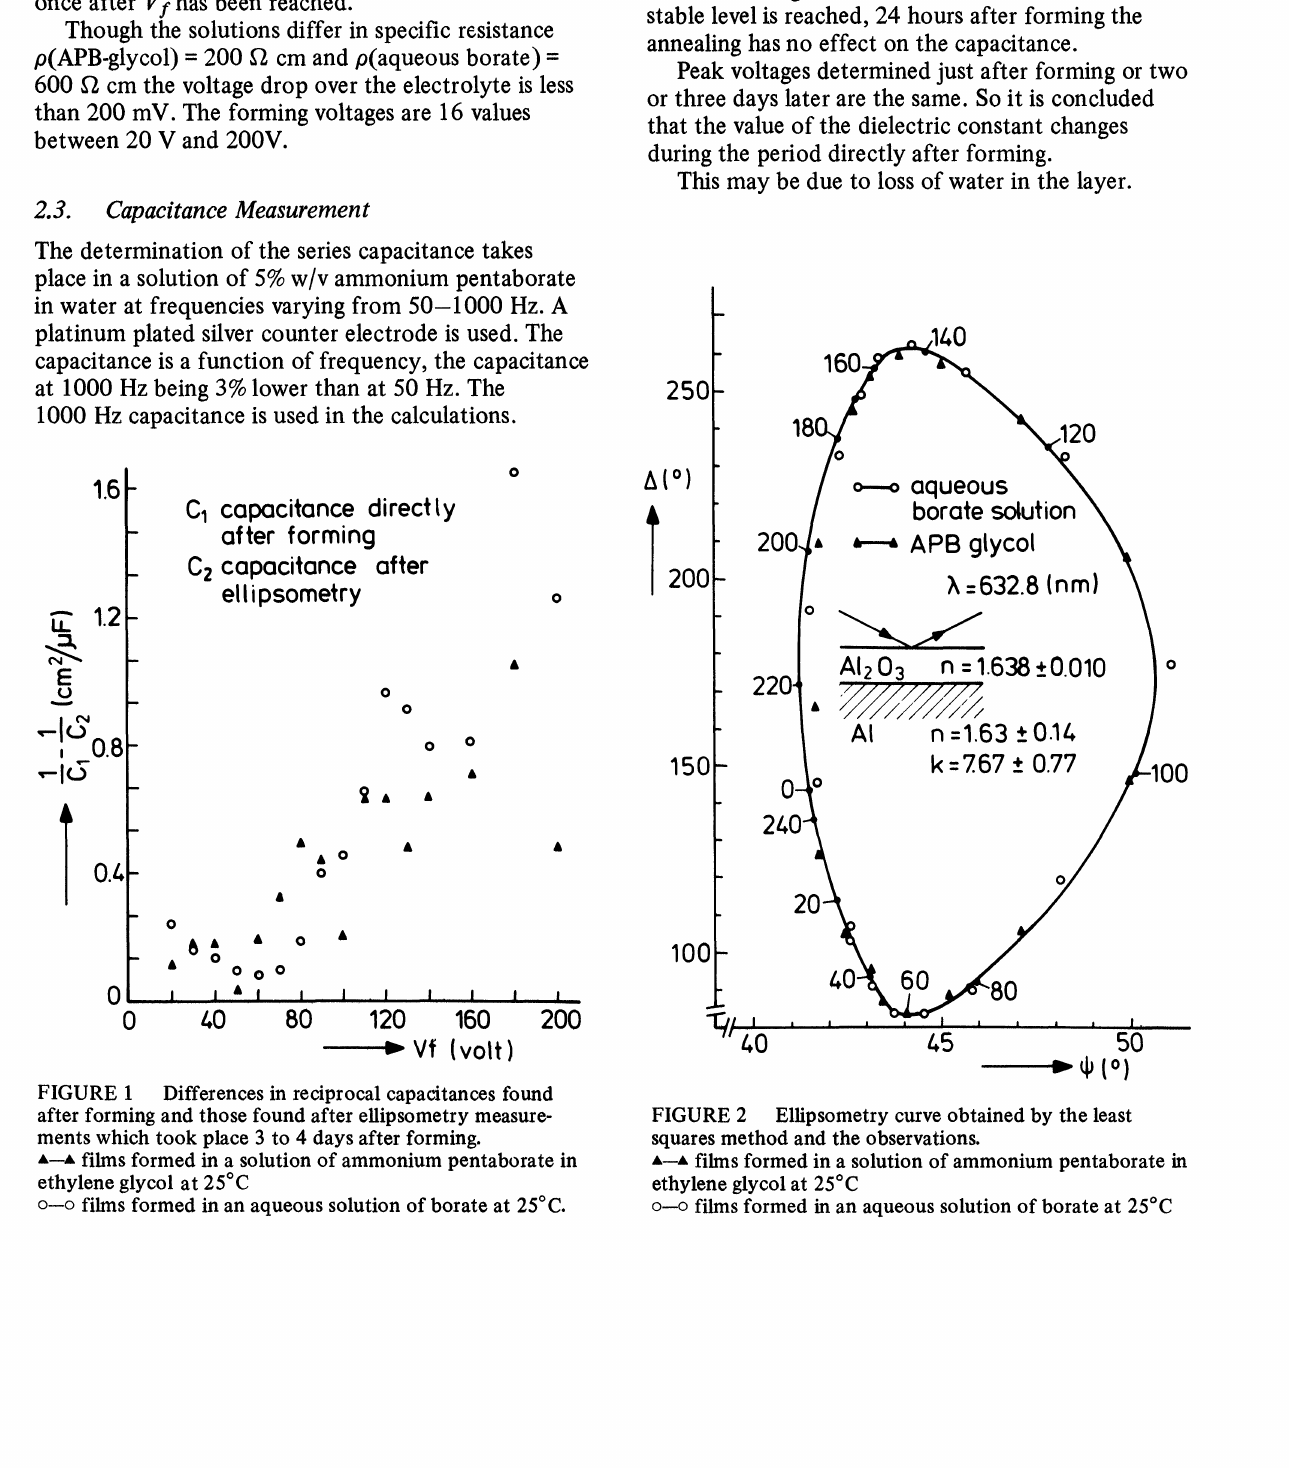
Ellipsometry curve obtained by the least squares method and the observations. A-- films formed in a solution of ammonium pentaborate in ethylene glycol at 25 C o--o films formed in an aqueous solution of borate at